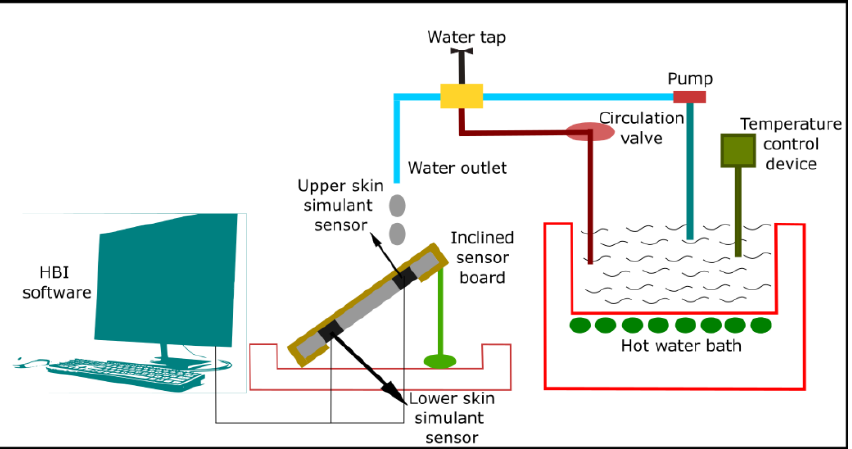
Figure 5. Thermal protective performance evaluating tester under hot water splash